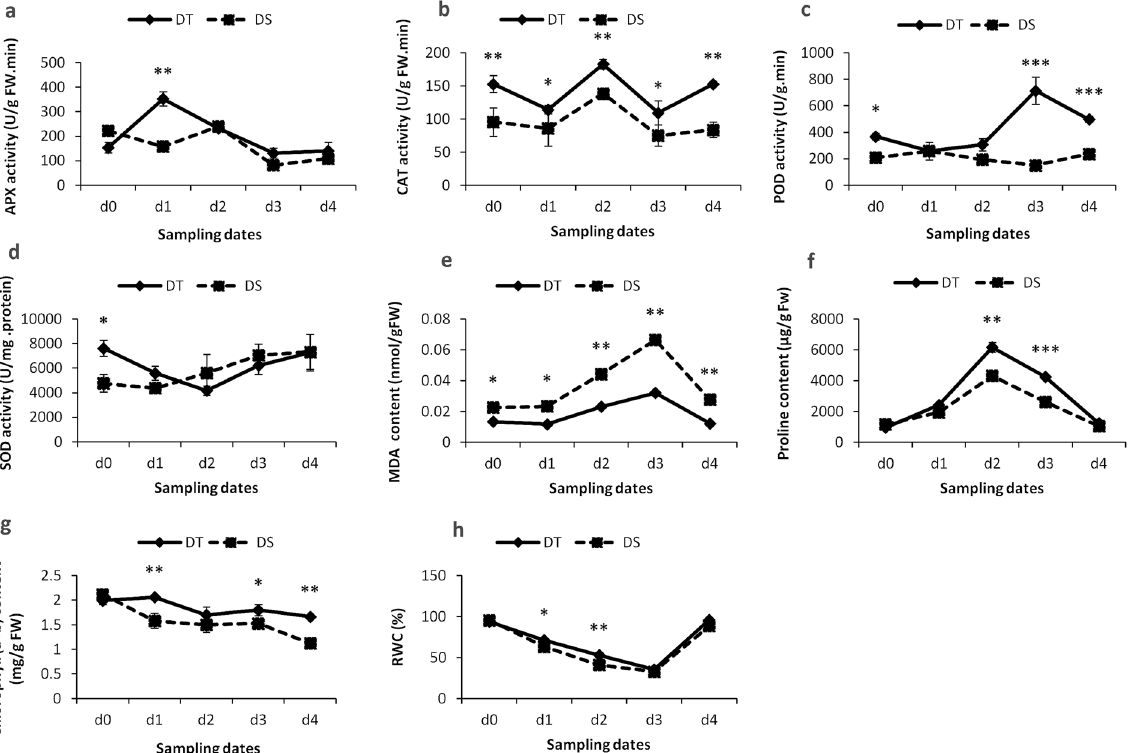
Figure 3. The effect of drought stress on the activity of ( a ) APX, ( b ) CAT, ( c ) POD, ( d ) SOD, ( e ) MDA, ( f ) proline, ( g ) total chlorophyll (a + b), ( h ) RWC, in the leaves of tolerant (DT) and sensitive (DS) sesame genotypes. Means and standard errors based on three replications are indicated. d 0 , d 1 , d 2 , d 3 and d 4 : plants stressed for 0, 3, 7, 11 days and 3 days of recovery after rewatering, respectively. * , ** , *** Significant differences based on Tukey’s multiple range test (P < 0.05, < 0.01 and < 0.001,